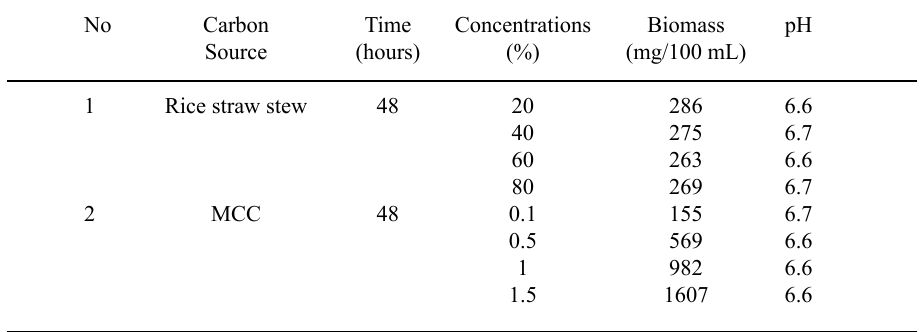
Table 2. P(3HB) content accumulated in P. aeruginosa cells after fermentation